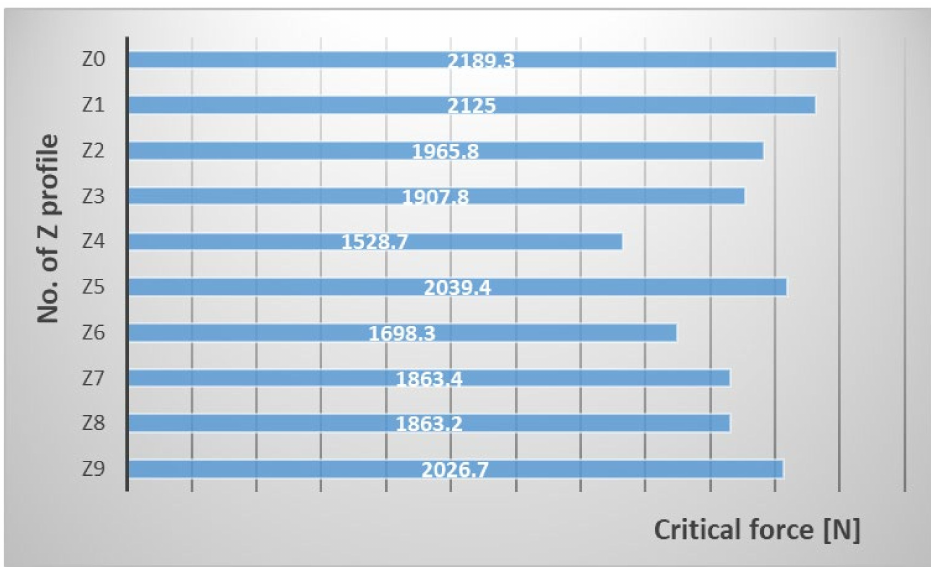
Figure 6. A graph showing the values of the critical